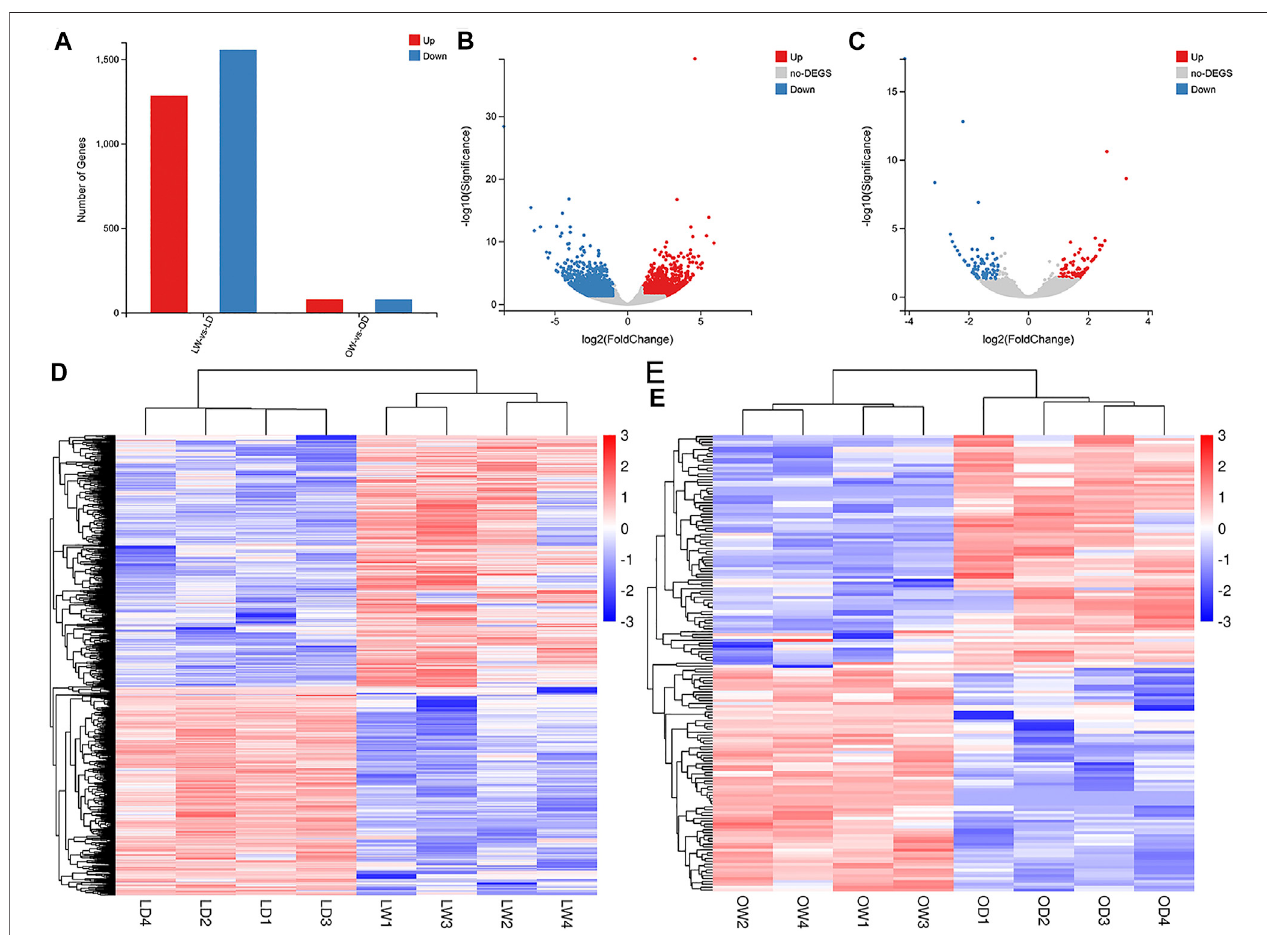
FIGURE5| Analysisofdifferentlyexpressed genes(DEGs)betweenthewildand captive-reared S.o ’ connori . (A) Number ofDEGs inliverand oocyte betweenthe wild and captive-reared S. o ’ connori . Volcano plot showing the DEGs in liver (B) and oocyte (C) . Hierarchical clustering of DEGs in liver (D) and oocyte (E) . Each row represents a gene and each column represents a sample. Each cell in the matrix corresponds to an expression level, with blue for under-expression, red for overexpression, and white for gene expression close to the median (see color scale). LW, liver from wild S. o ’ connori ; LD, liver from domestic S. o ’ connori ; OW, oocyte from wild S. o ’ connori ; OD, oocyte from domestic S. o ’ connori .